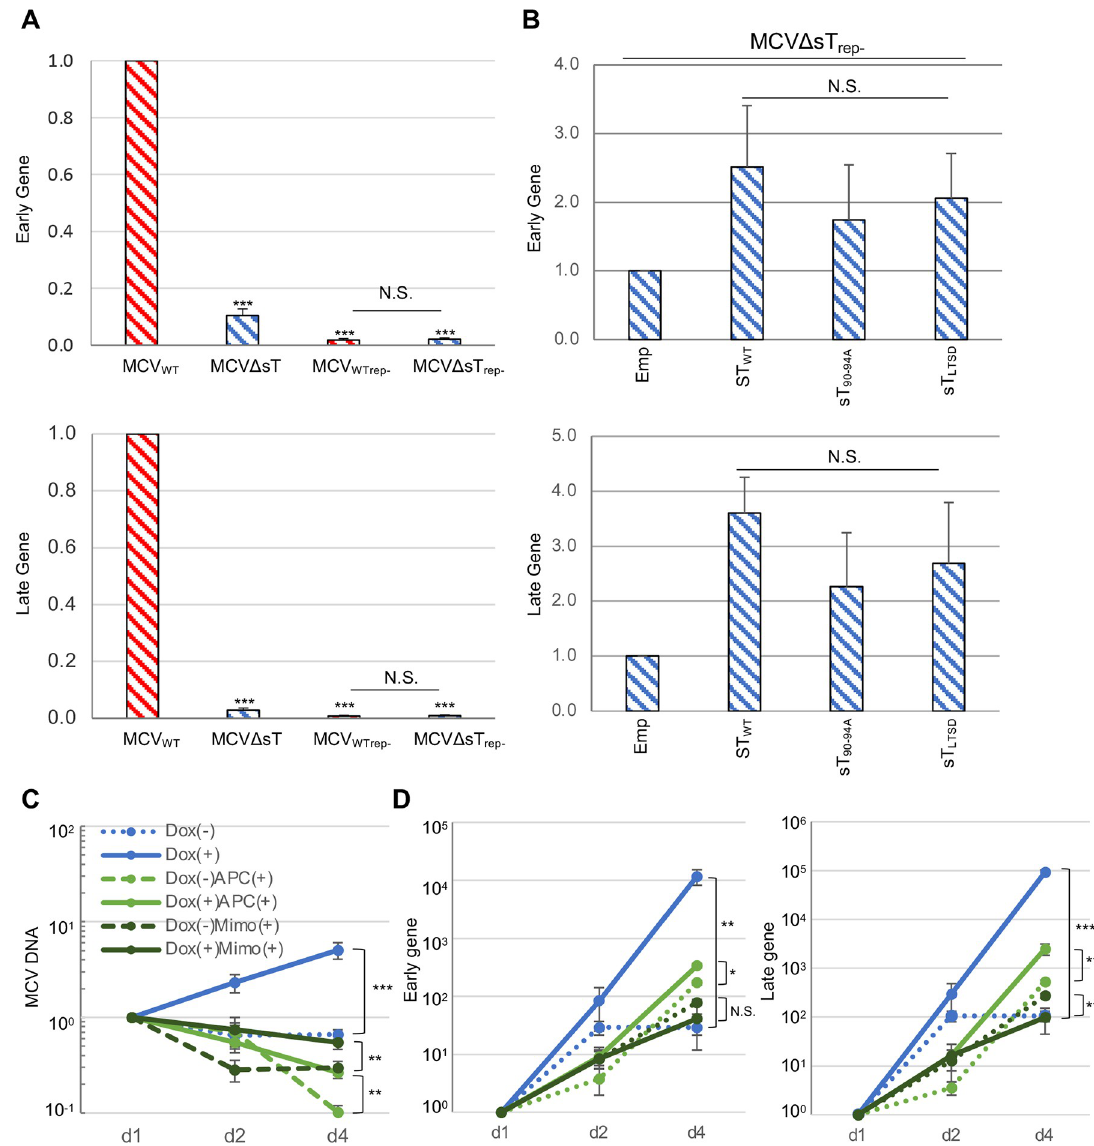
Fig 4. sT requires viral DNA replication for an efficient activation of viral gene expression. (A) 293 cells transfected with MCV WT , MCV Δ sT, and their rep- counterparts were harvested at day 4. Total extracted RNA was subjected to qRT-PCR analysis by the 2 - ΔΔ Ct method with 18S ribosomal RNA for normalization. Relative mRNA expression to the MCV WT -transfected sample is shown. Error bars indicate SD. (B) 293 cells co-transfected with MCV Δ sT rep- and either pcDNA empty (Emp), pcDNA sT WT , or LTSD mutants (pcDNA sT 90-94A and pcDNA sT LTSD ) were harvested at day 4. Early and late gene expression was determined as in Fig 4A. Relative mRNA expression to the pcDNA6 empty co-transfected sample is shown. (C) 293 TRE-sT cells that can inducibly express sT by doxycycline were transfected with MCV Δ sT in 13 dishes. At day 1 p.t., cells in one dish were harvested and doxycycline (0.5 μ g/mL), DNA inhibitors (5 μ M aphidicolin (APC) and 400 μ M mimosine (Mimo)), and water (for mock) were added to the other 12 dishes. The remaining cells were harvested at day 2 and 4 p.t. To examine viral DNA replication, qPCR was performed, as described in the Fig 2A legend. (D) Using the same samples as in Fig 4C, RNA was extracted and converted to cDNA for qRT-PCR analysis, as described in the Fig 2B legend, to determine early and late gene